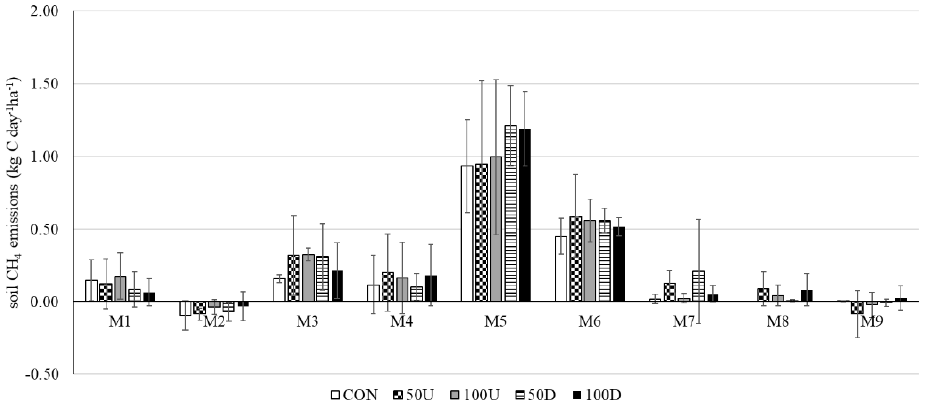
Figure 4. CH 4 emission fluxes (kg C day −1 ha −1 ) during the growing cycle for the control (CON), urea 50 kg N ha −1 (50 U), urea 100 kg N ha −1 (100 U), digestate 50 kg N ha −1 (50 D), and digestate 100 kg N ha −1 (100 D). Letters are not displayed since no statistical differences were observed between treatments ( p < 0.05)).